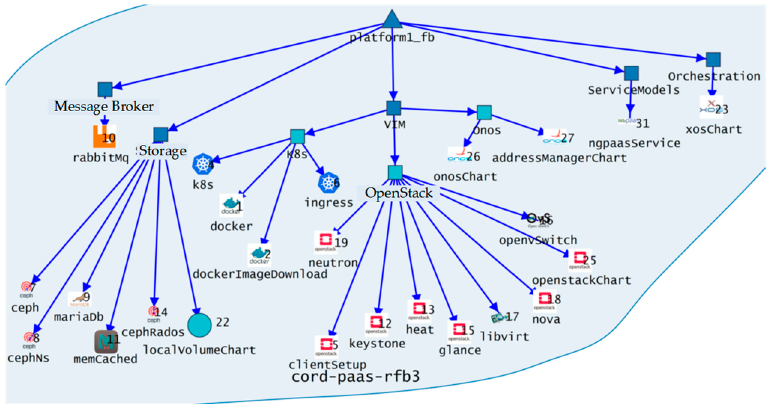
Figure 13. RFBisation of the CORD platform via RDCL 3D.